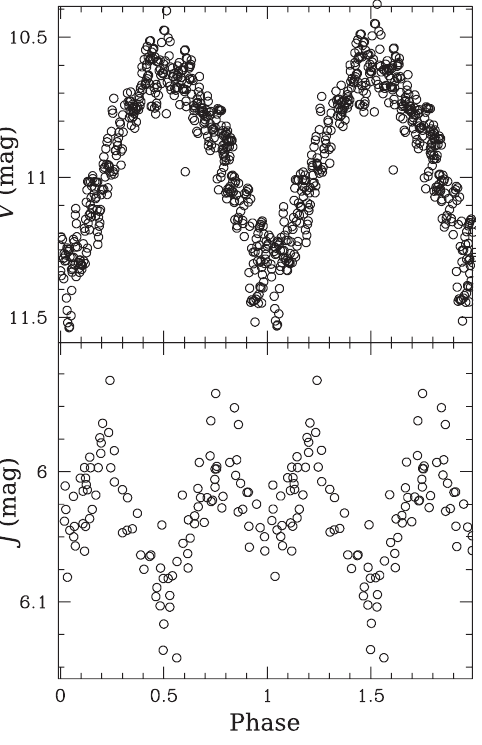
Fig. 3. V (ASAS database; Pojma´nski 2002) and J (Rutkowski et al. 2007) light curves of SY Mus phased with the orbital period of 624.5 d. The ellipsoidal variability is visible only in the near infrared